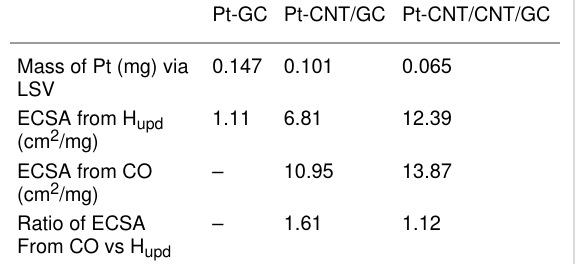
Table 1: Pt mass on the different supports and corresponding electro- chemically active surface area (ECSA) determined by H upd and CO ads .